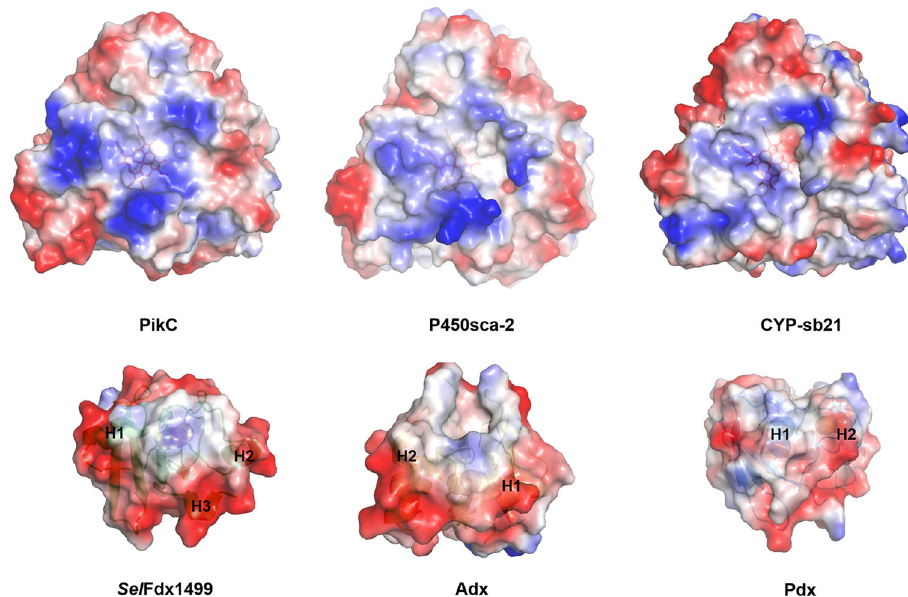
Fig. 4 Electrostatic surface analysis of P450s and Fdxs. Positively and negatively charged surfaces are colored in blue and red, respectively. The electrostatic surfaces of Fdxs with Helix1 (H1), Helix2 (H2), or Helix3 (H3) are marked. The six proteins are PikC/YC-17 (PDB ID: 2VZ7), P450sca-2 (predicted by Alphafold2), CYP-sb21 (substrate-free, PDB ID: 6M4S), Sel Fdx1499 (predicted by Alphafold2), Adx (PDB ID: 1CJZ), and Pdx (PDB ID: